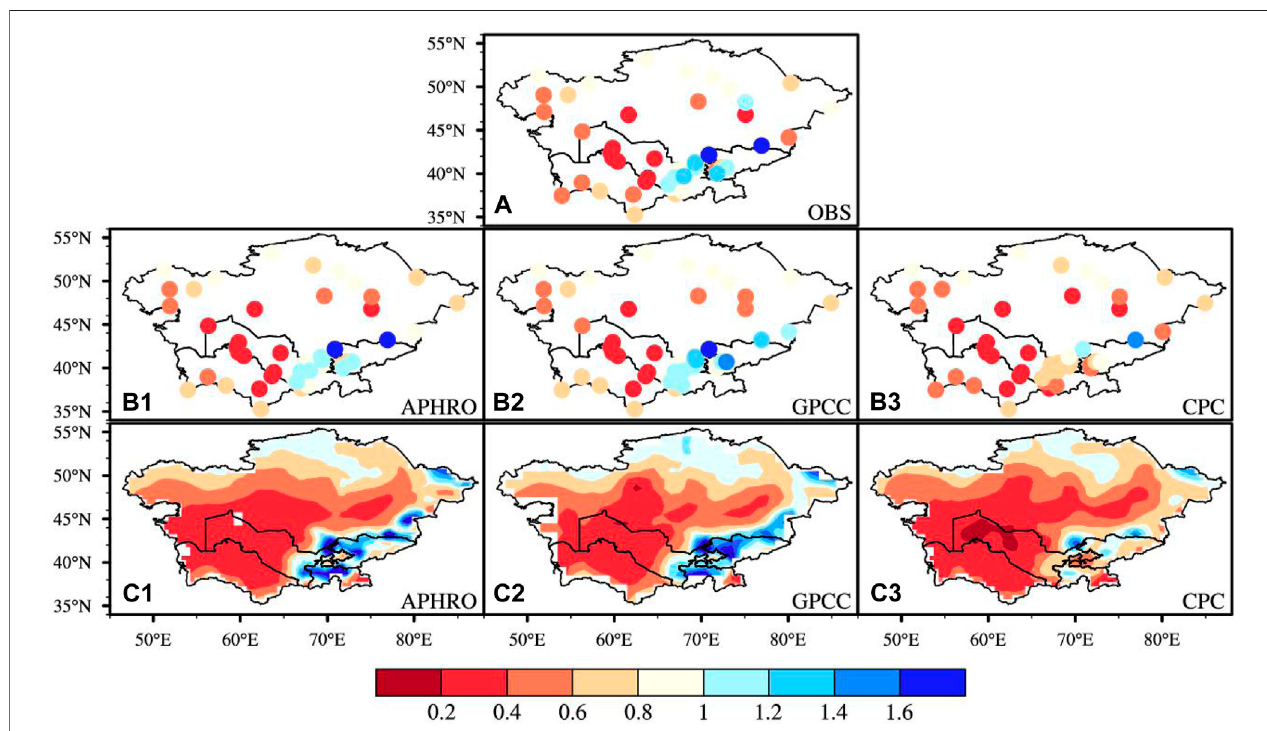
FIGURE3 | Spatial patternsofdaily mean precipitation for gauge-observed and three gauge-based gridded products in theCA during 1985 − 2005. (A) , OBS; (B1 And C1) APHRODITE; (B2 And C2) , GPCC; (B3 And C3) , CPC. unit: mm/day.